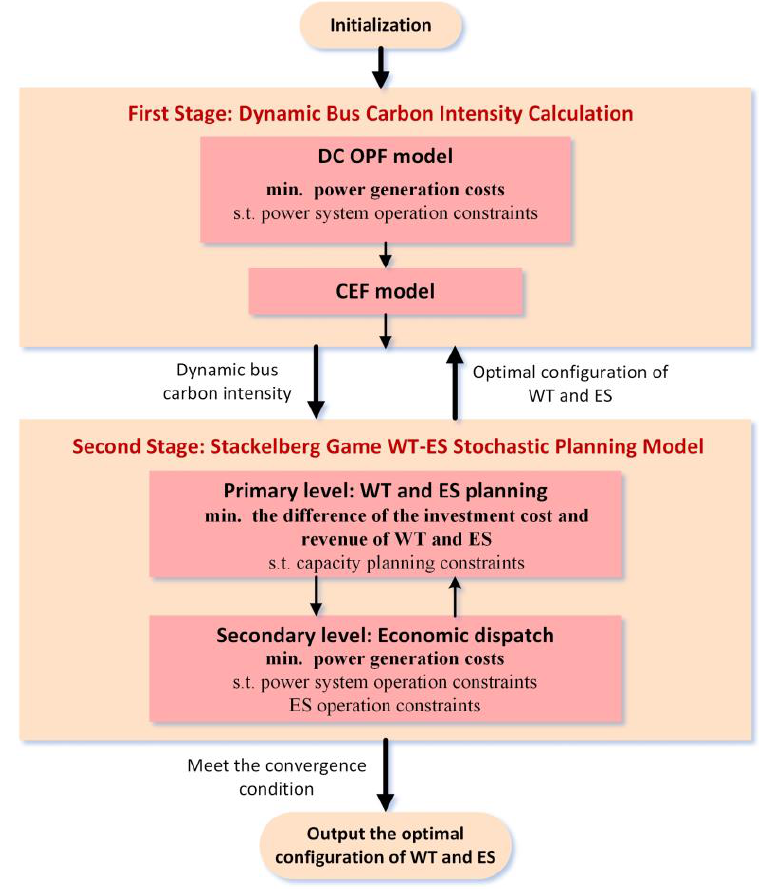
Figure 1. Two-stage model framework.